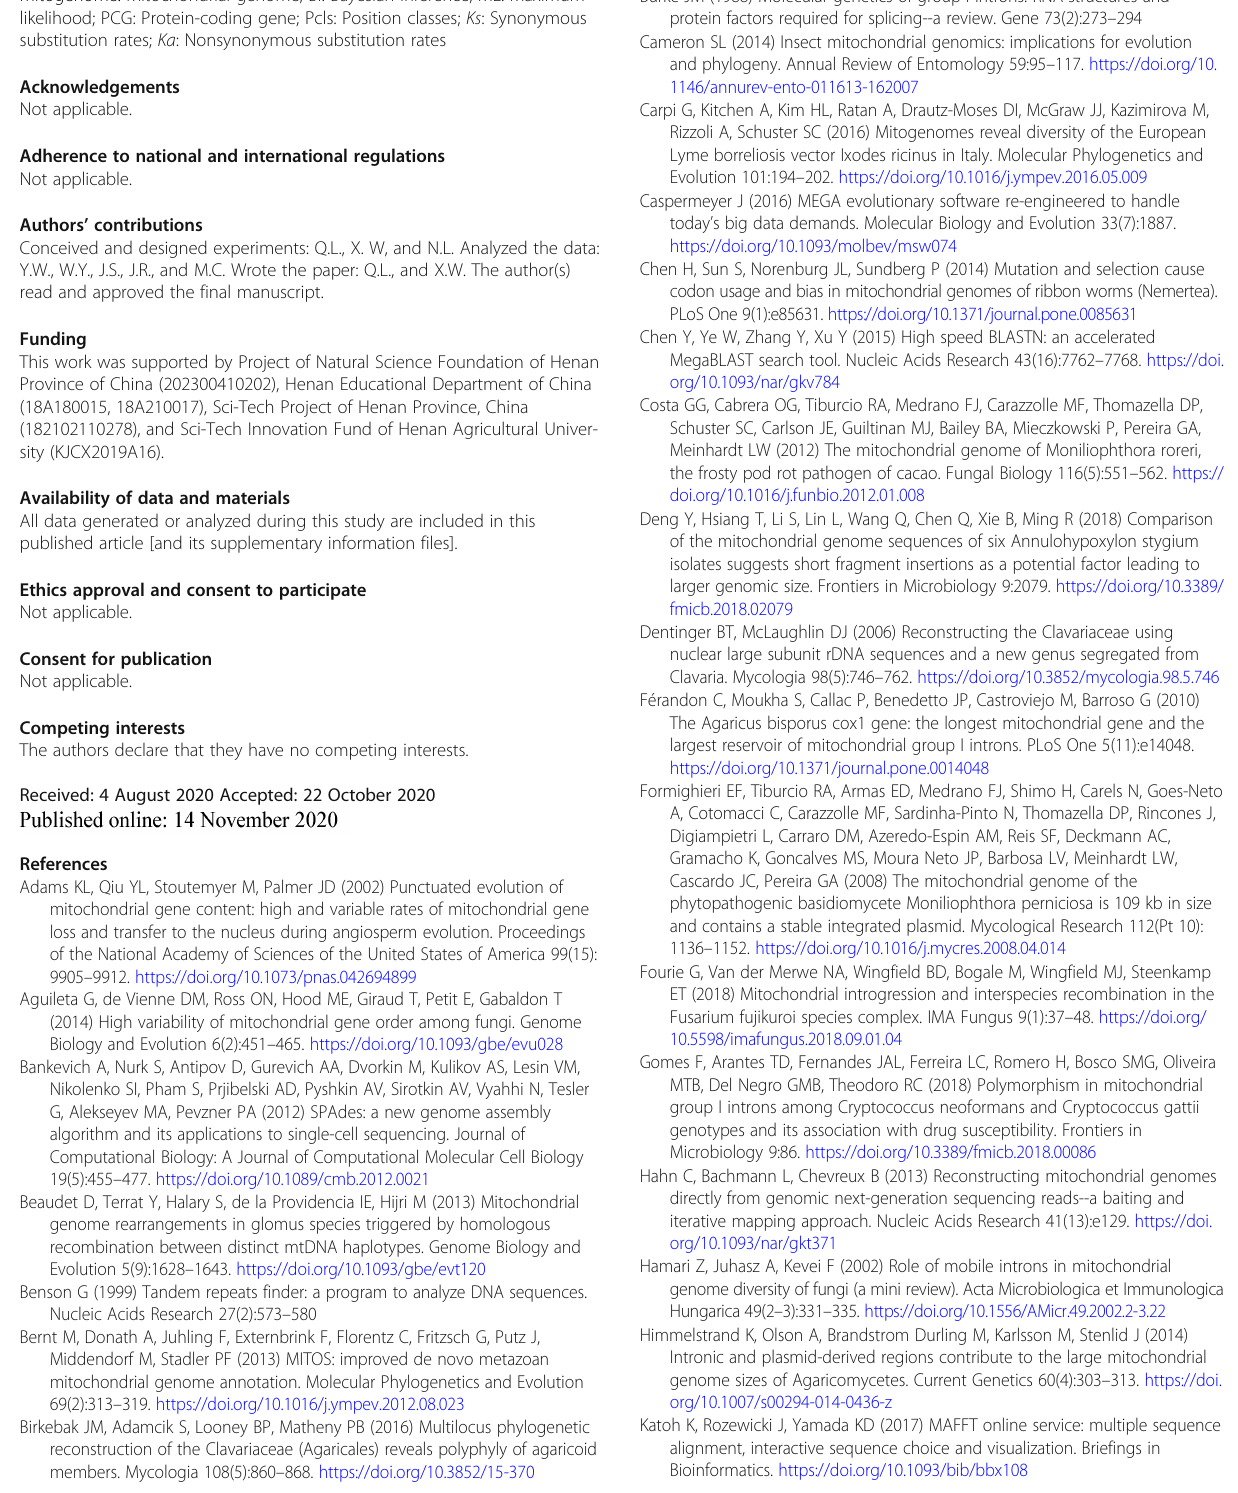
Table S8. Species, and GenBank accession number used for phylogen- etic analysis in this study. Abbreviations mitogenome: Mitochondrial genome; BI: Bayesian inference; ML: Maximum likelihood; PCG: Protein-coding gene; Pcls: Position classes; Ks :